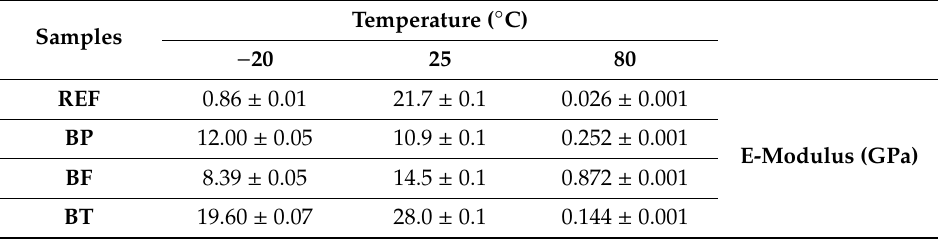
Table A1. Appendix A contains details and data supplemental to Figure 13.